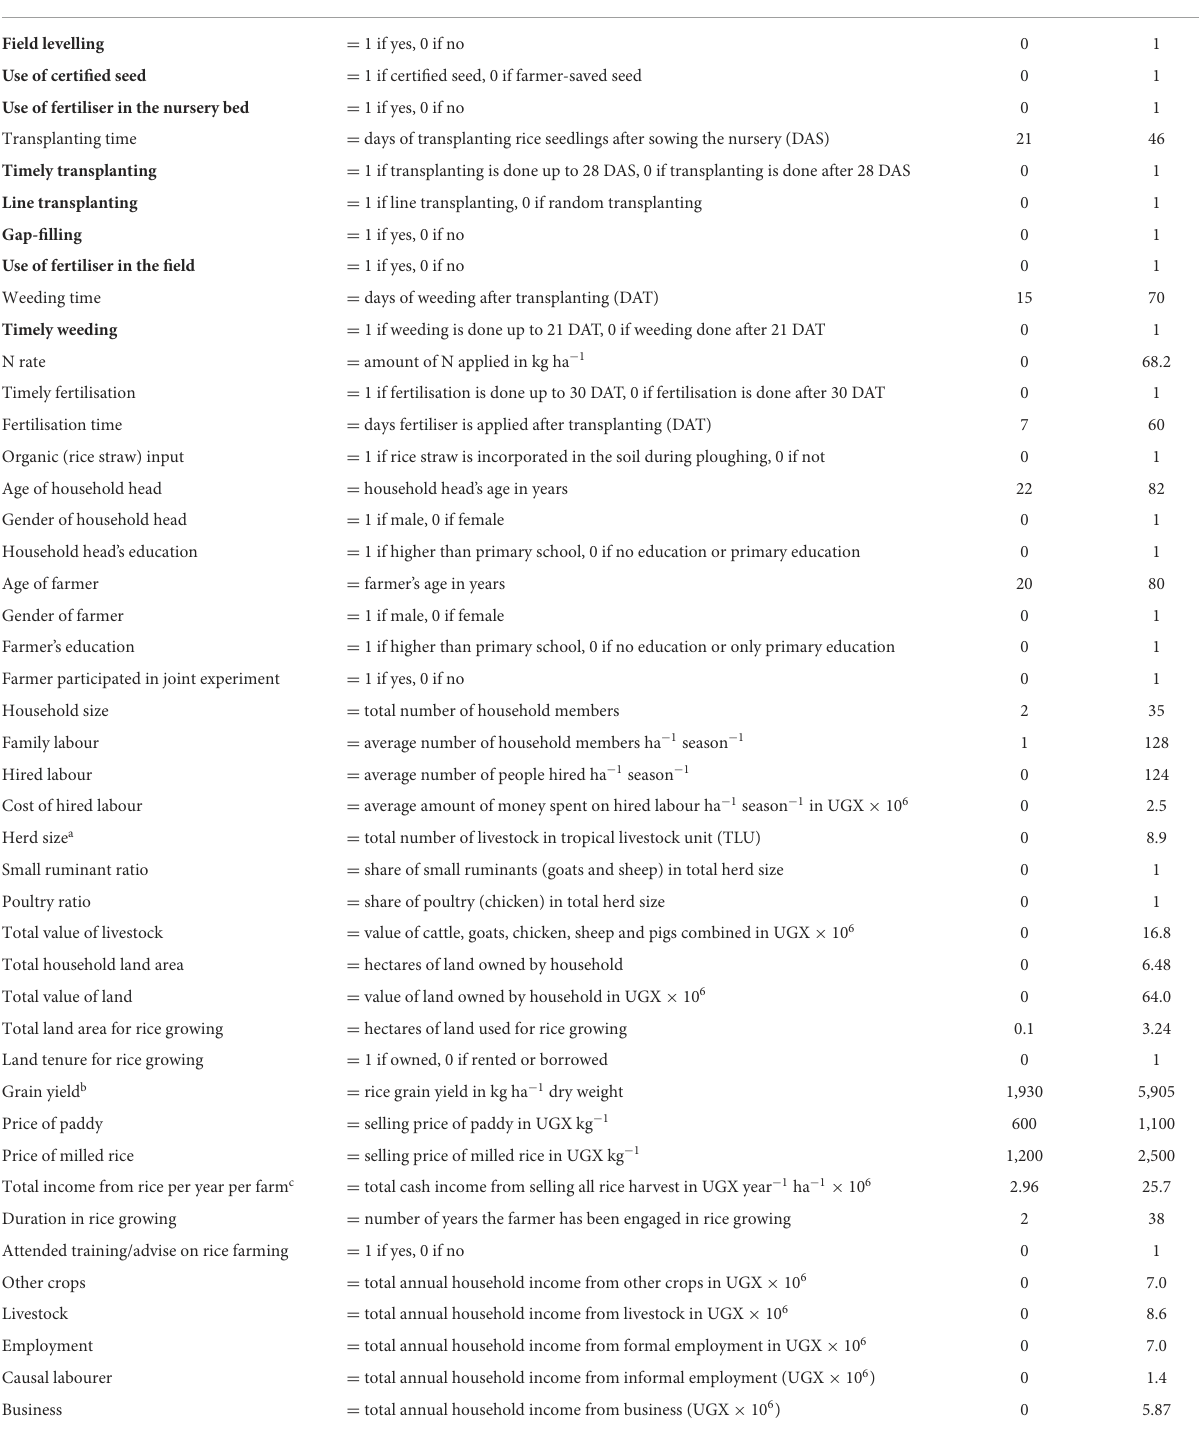
TABLE 1 Description of variables, units, and minimum and maximum values of variables used in the principal component analysis (PCA) and cluster analysis (CA), and the subsequent characterisation of farm types. Name of